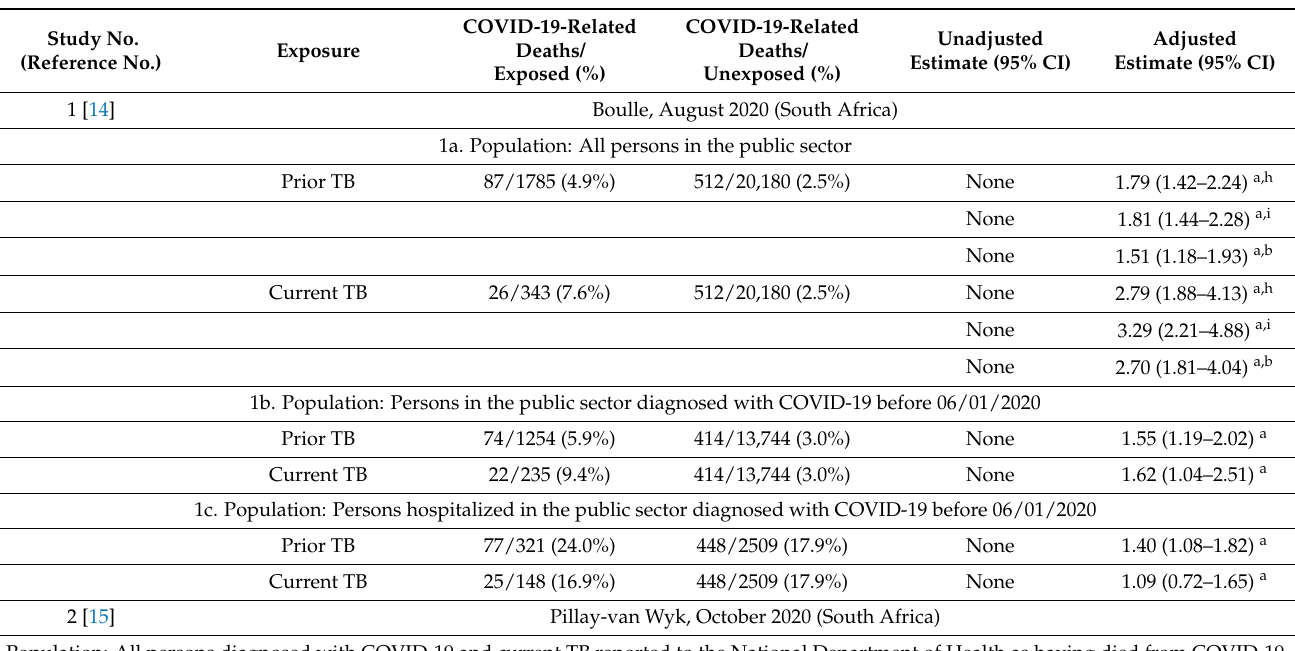
Table 2. Effect estimates for the association between TB and mortality related to COVID-19, by study.